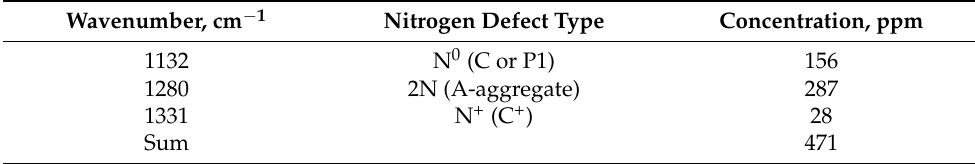
Table 3. Concentration of nitrogen defects according to FTIR